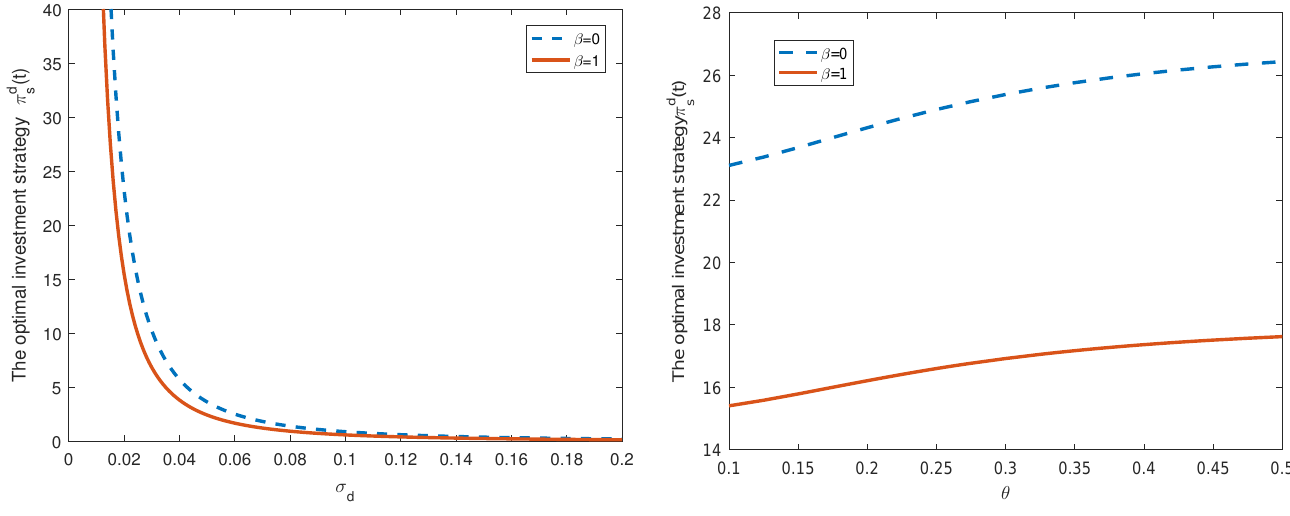
Figure 1. The impact of parameters σ d and θ on π d s ( t )